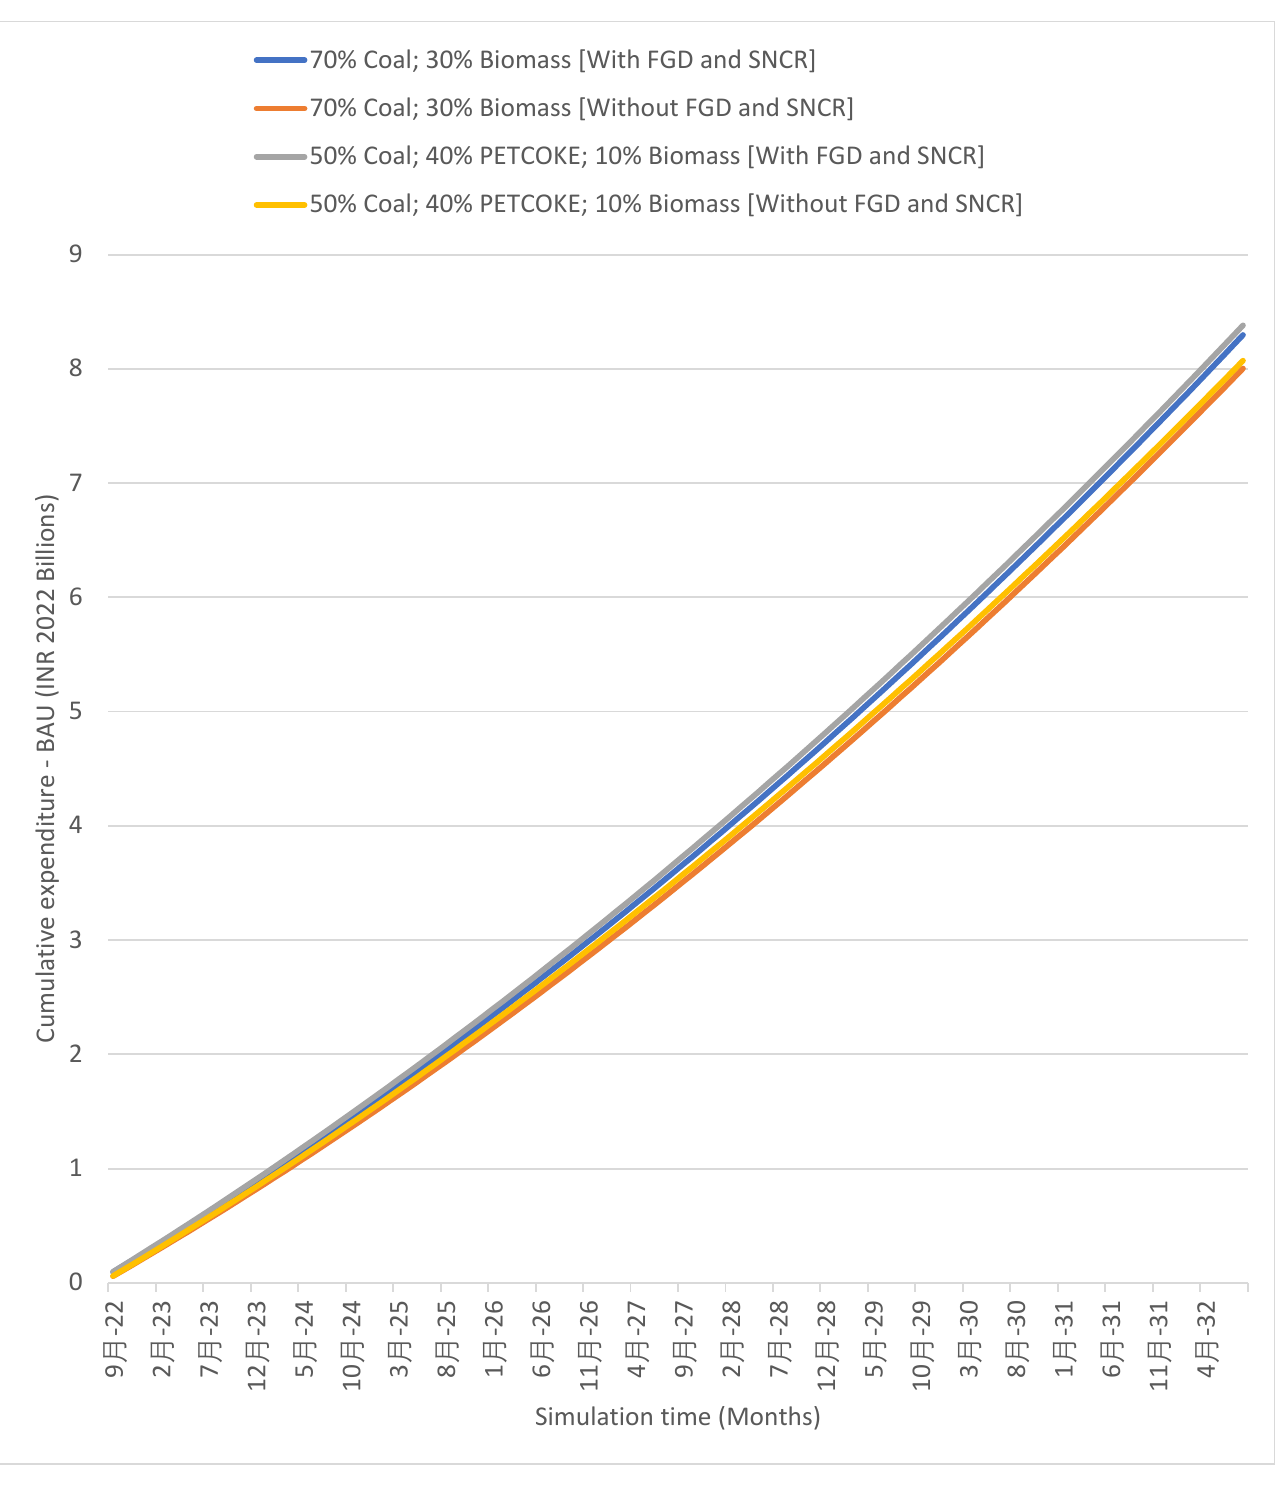
Figure 8. Cumulative expenditure under BAU scenario for selected fuel-mix configurations, with and without FGD and SNCR systems.